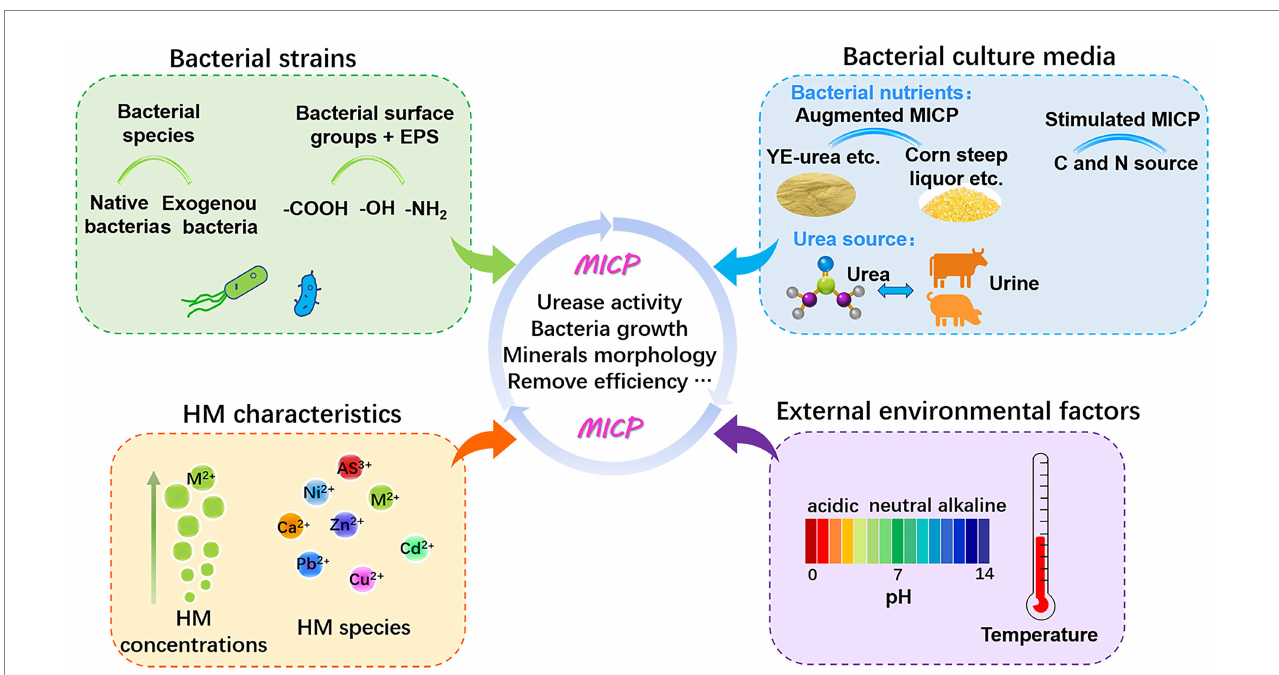
FIGURE 3 Key factors influencing the performance of MICP